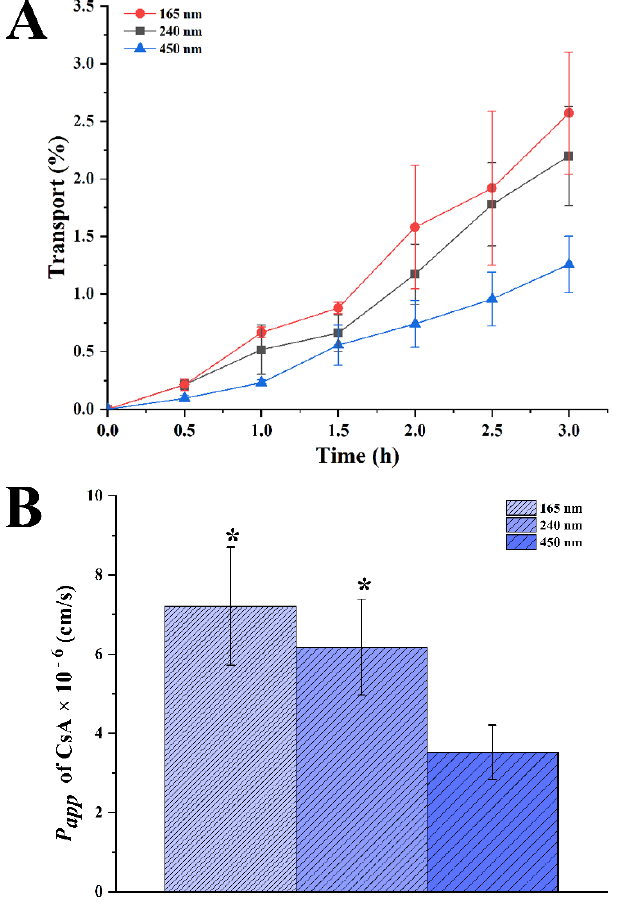
Figure 8. ( A ) Relative cumulative transport of CsA in CsA-NCs across Caco-2 monolayer; ( B ) Ap- parent permeability coefficient (P app ) of CsA across a Caco-2 cell monolayer ( n = 3, Mean ± SD). * represents significantly different compared with CsA-NC (450 nm) ( p <